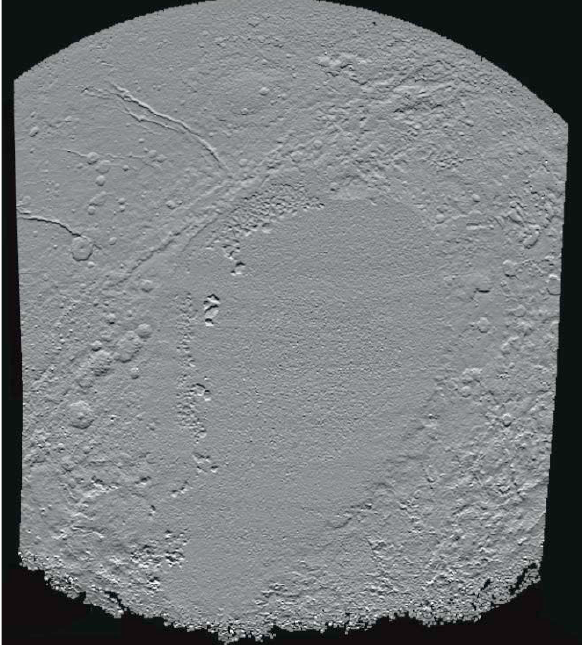
Figure 3. Shaded-relief map of part of Pluto, showing the relatively smooth giant depression associated with Sputnik Planum (center of image), flanked by massifs and eroded arcuate